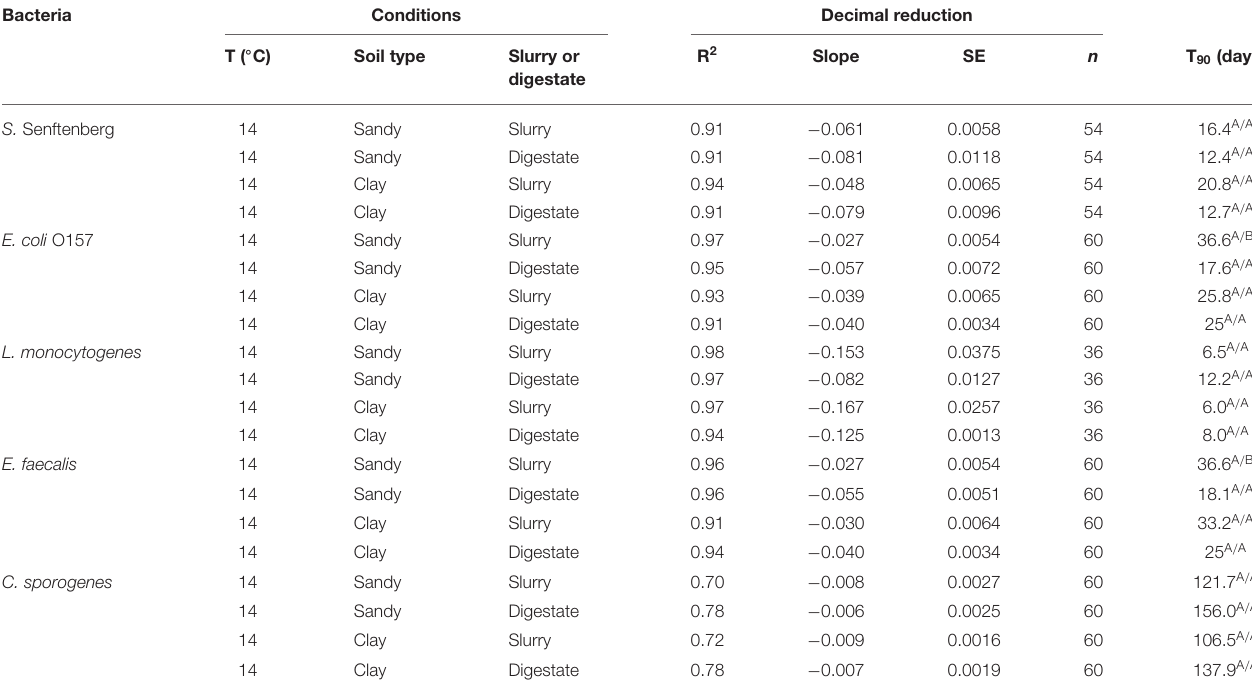
TABLE 3 | T 90 values for the different bacteria applied in slurry and digestate to sandy loam and clay loam soils and stored at 14 ◦ C in the laboratory trials.